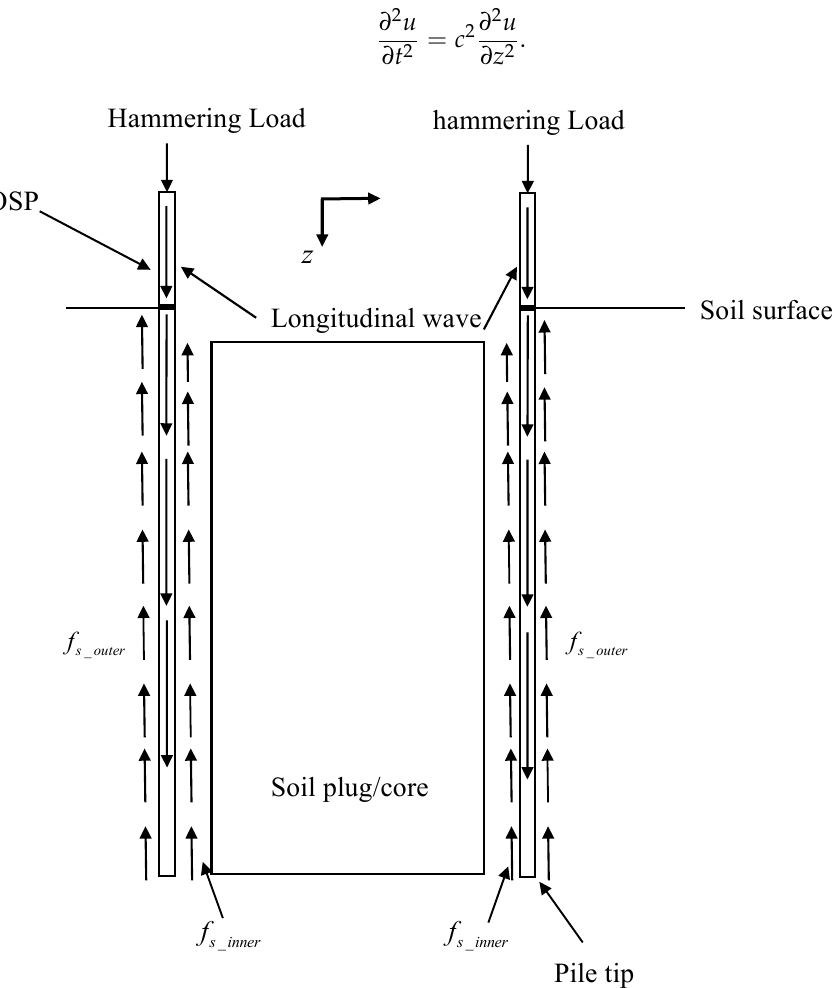
Figure 2. Load transfer of LOSP under hammering load .